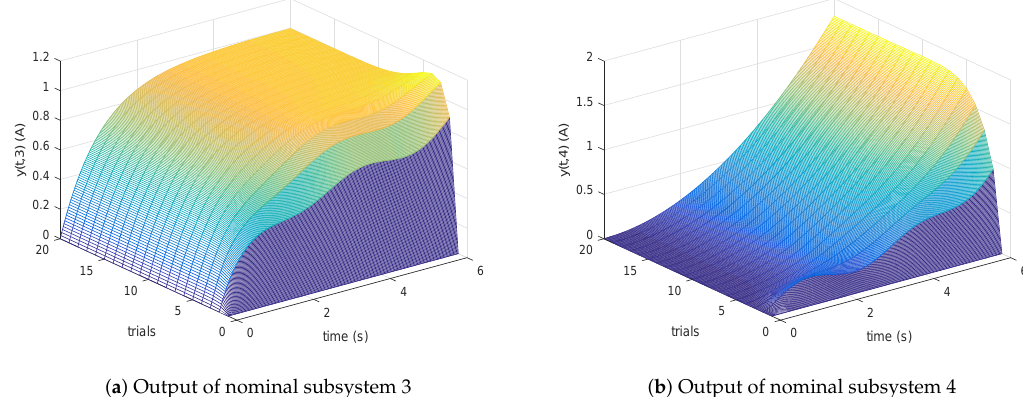
Figure 4. Outputs of nominal subsystems 3 and